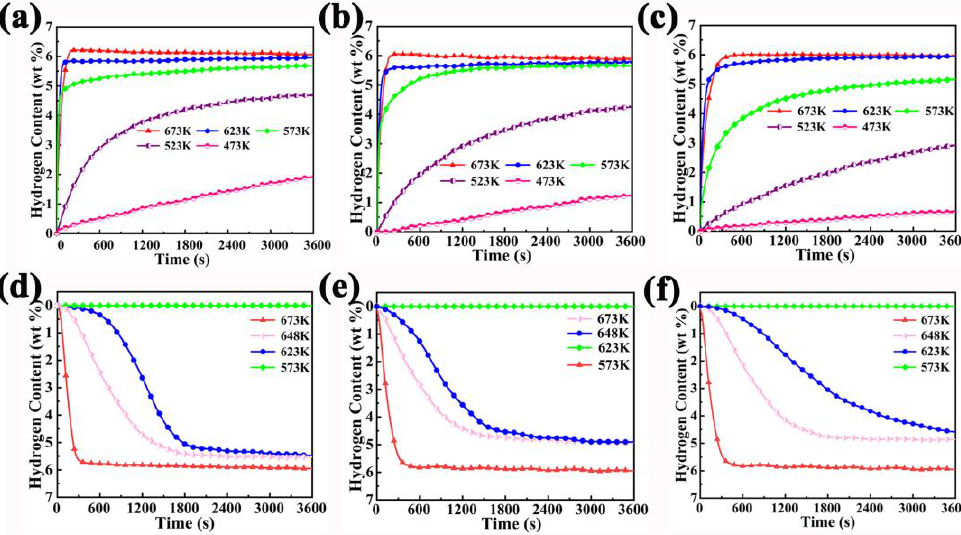
Figure 4. The kinetics curves of hydrogen absorption for MgH 2 -2.5 wt% ZnO ( a ); MgH 2 -5 wt% ZnO ( b ); MgH 2 -7.5 wt% ZnO ( c ); and the kinetics curves of hydrogen desorption for MgH 2 -2.5 wt% ZnO ( d ); MgH 2 -5 wt% ZnO ( e ); MgH 2 -7.5 wt% ZnO ( f ) at different temperatures.